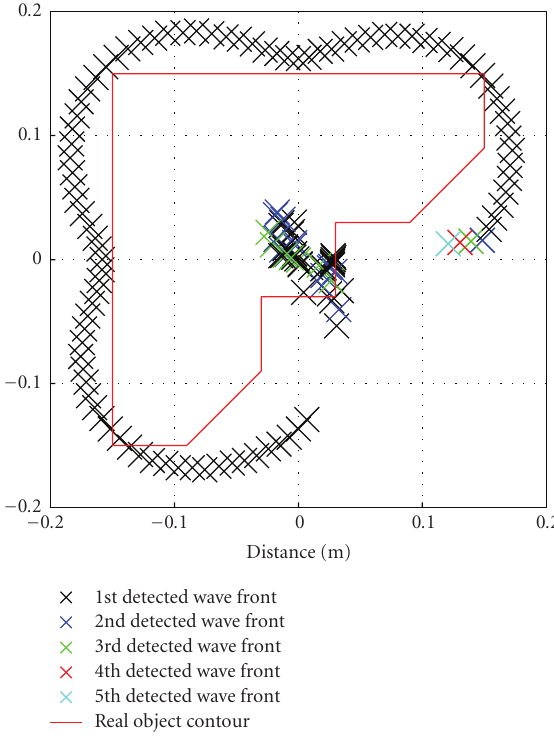
Figure 6: Detection of multiple reflections of a complex cascaded object.